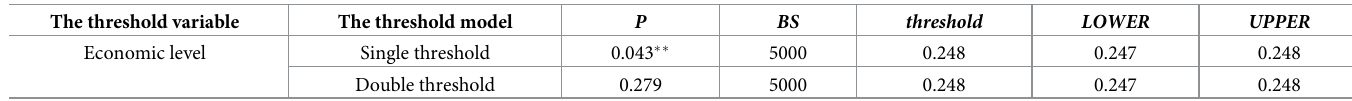
Table 6. Threshold